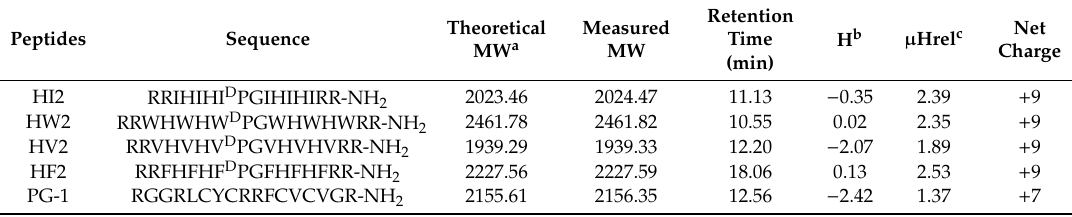
Table 1. Peptides design and key physicochemical